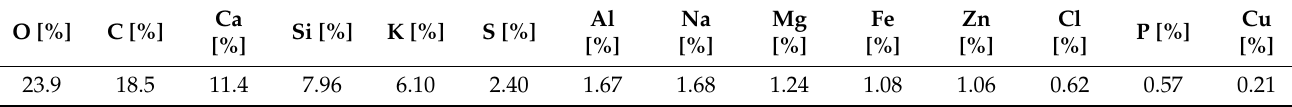
Table 11. Emission factors.